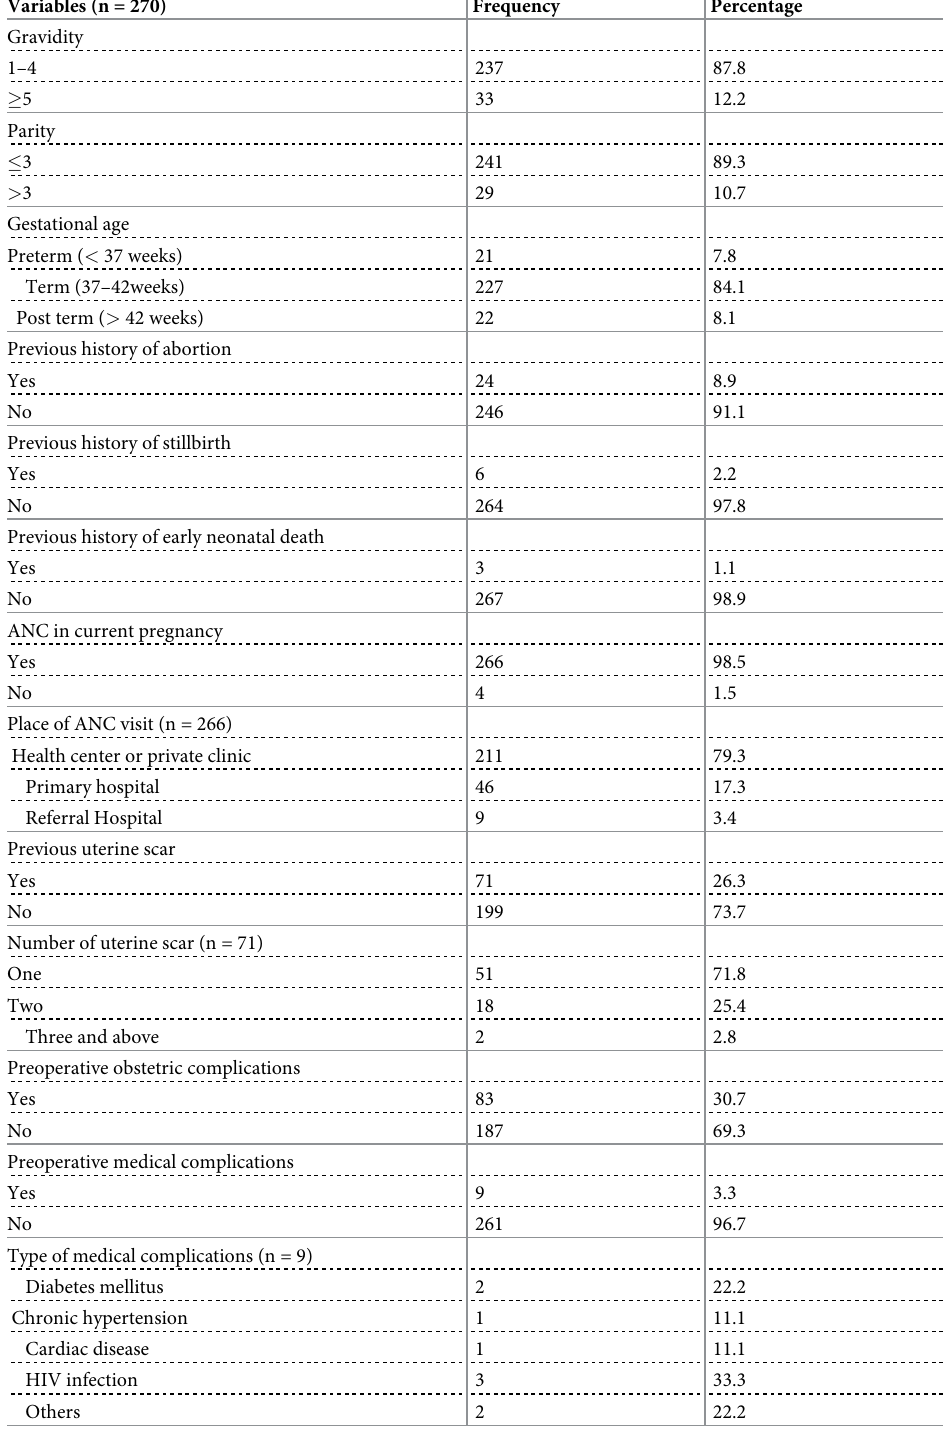
Table 2. Obstetric profile of respondents in Hawassa University comprehensive specialized hospital, Southern Ethiopia, October